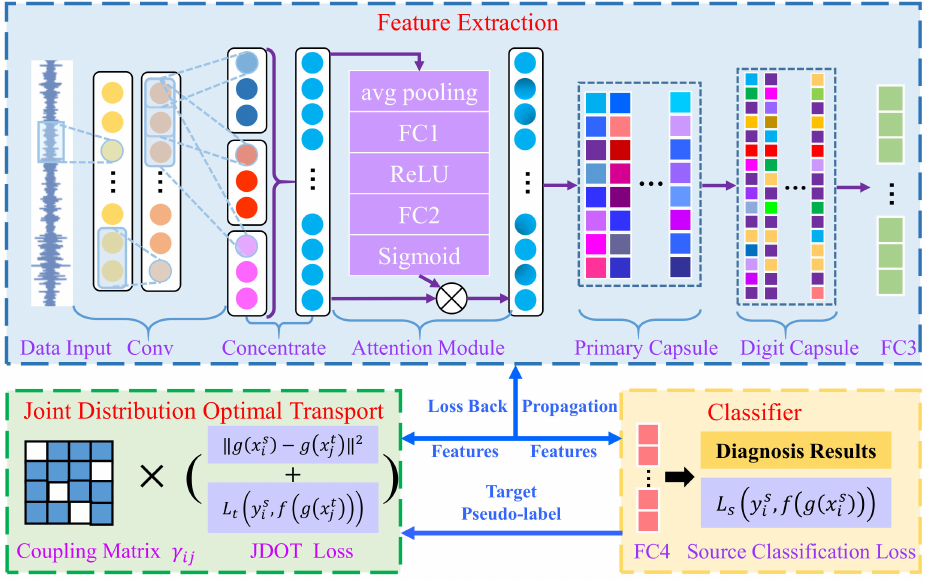
Figure 2. Architecture of the